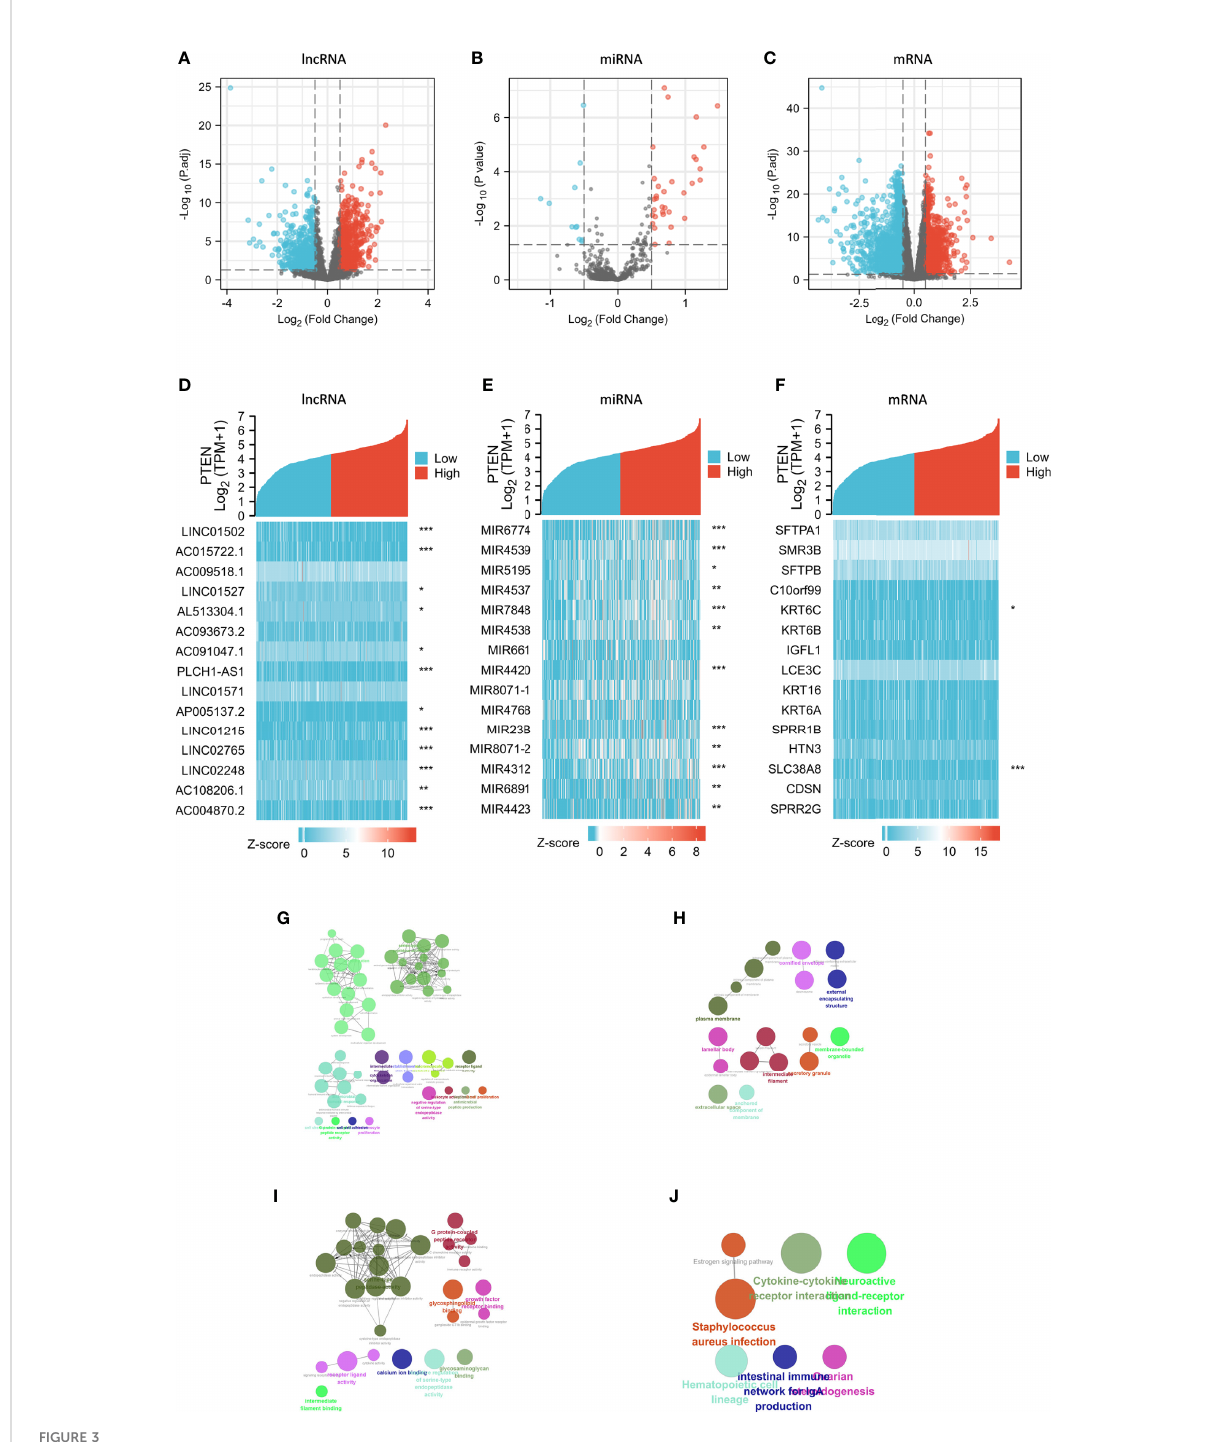
FIGURE 3 Analysis of DElncRNAs, DEmiRNAs, and DEmRNAs in groups characterized by PTEN high and PTEN low expression in the SKCM dataset. Red represents upregulated genes and blue indicates downregulated genes. Volcano plots describing (A) 1457 DElncRNAs (|log2 FC| > 0.5, adjusted p value < 0.05), (B) 44 DEmiRNAs (|log2 FC| > 0.5, adjusted p value < 0.05), and (C) 3339 DEmRNAs (|log2 FC| > 0.5, adjusted p value < 0.05). (D – F) The horizontal axis of the heatmap corresponds to groups and the vertical axis to 15 signi fi cant DEGs (lncRNAs, miRNAs, and mRNAs). (G – J) GO and KEGG analyses of signi fi cantly upregulated DEmRNAs in the PTEN low group using Cytoscape. The color indicates a class of biological functions, whereas the size of the circle indicates the degree of signi fi cance. *p < 0.05, **p < 0.01, ***p <